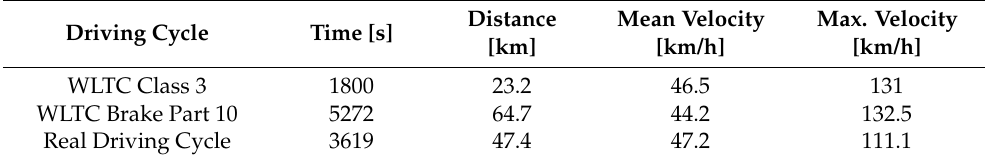
Table 1. Key parameters of the investigated driving cycles: WLTC Class 3b, WLTC Brake, and a real driving